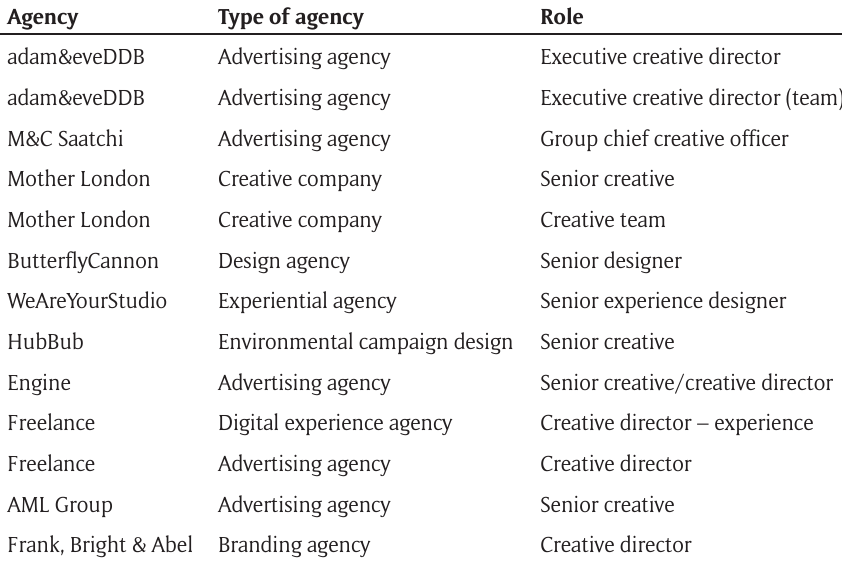
Table 1: Advertising creatives in the research